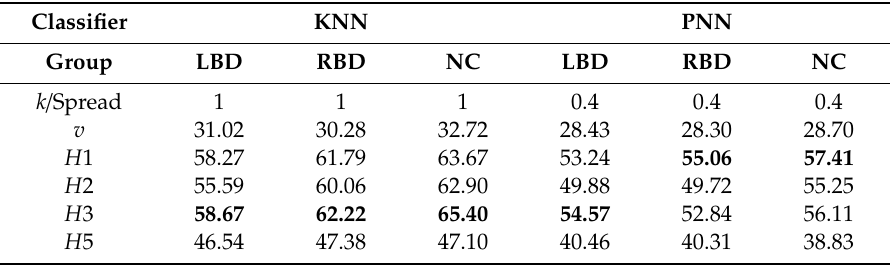
Table 3. Summary of average accuracy of all emotions of di ff erent bispectrum features using the combination of alpha to gamma bands.